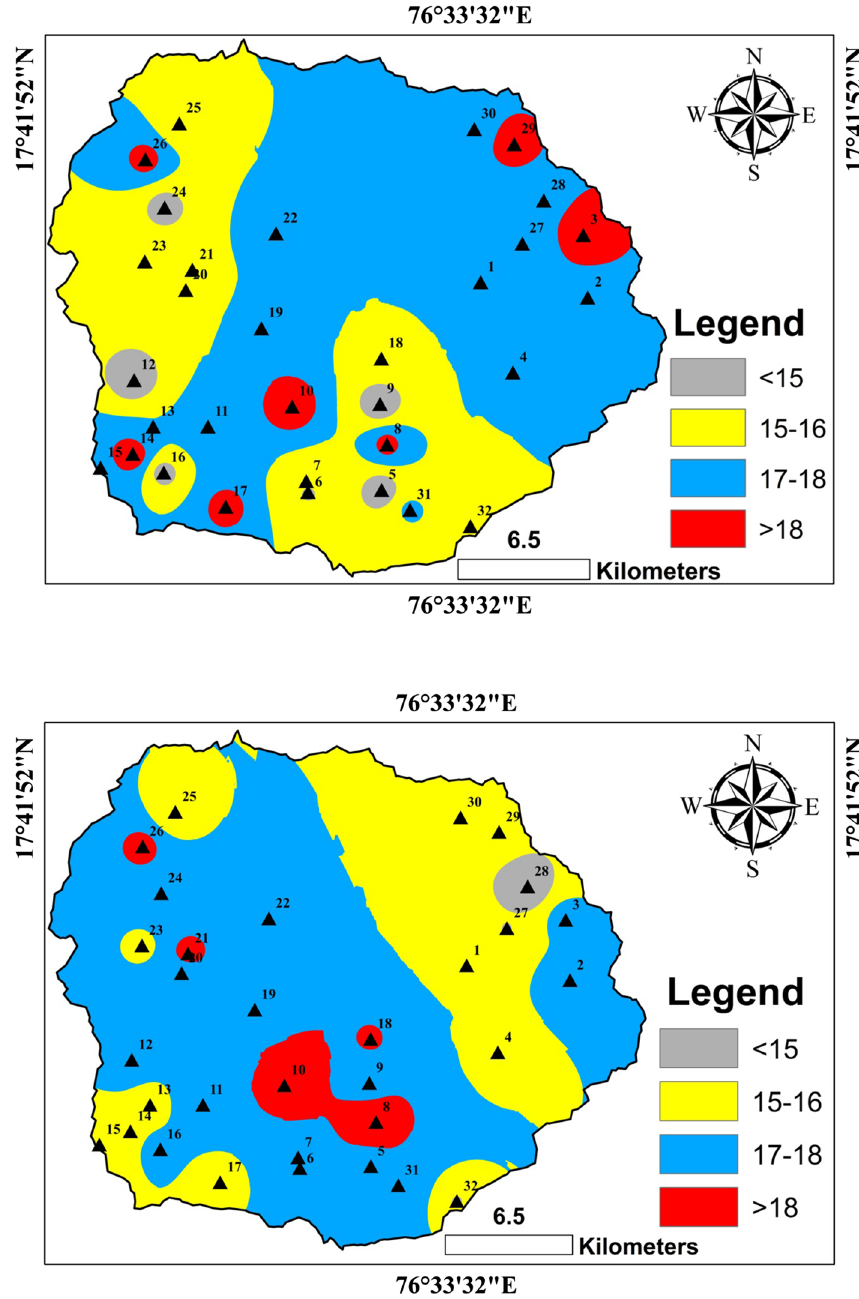
Fig. 14 Geospatial distribution of potassium (pre-monsoon)